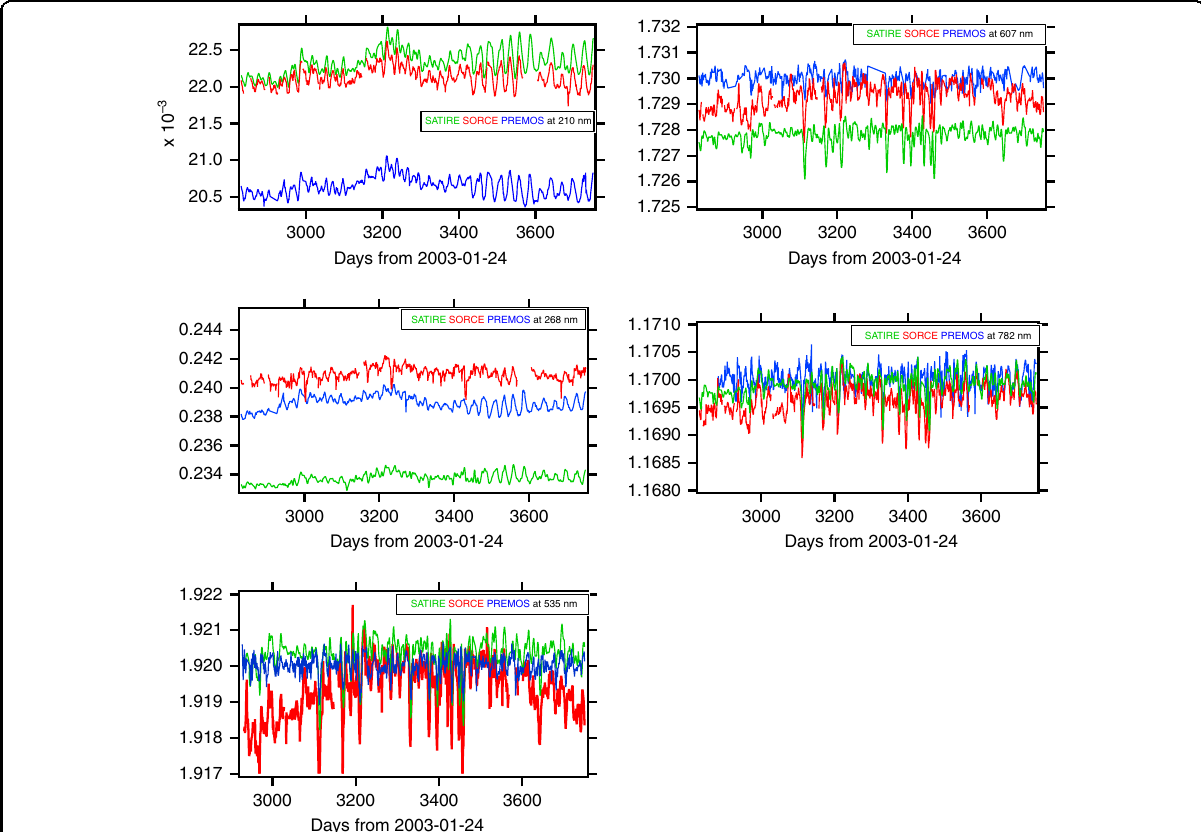
Fig. 4 Time series measured by PREMOS and SORCE v17 and SATIRE model during the PICARD. These datasets are compared at 210, 268, 535, 607 and 782 nm wavelength. The date format is the same as for Figs. 2 and 3